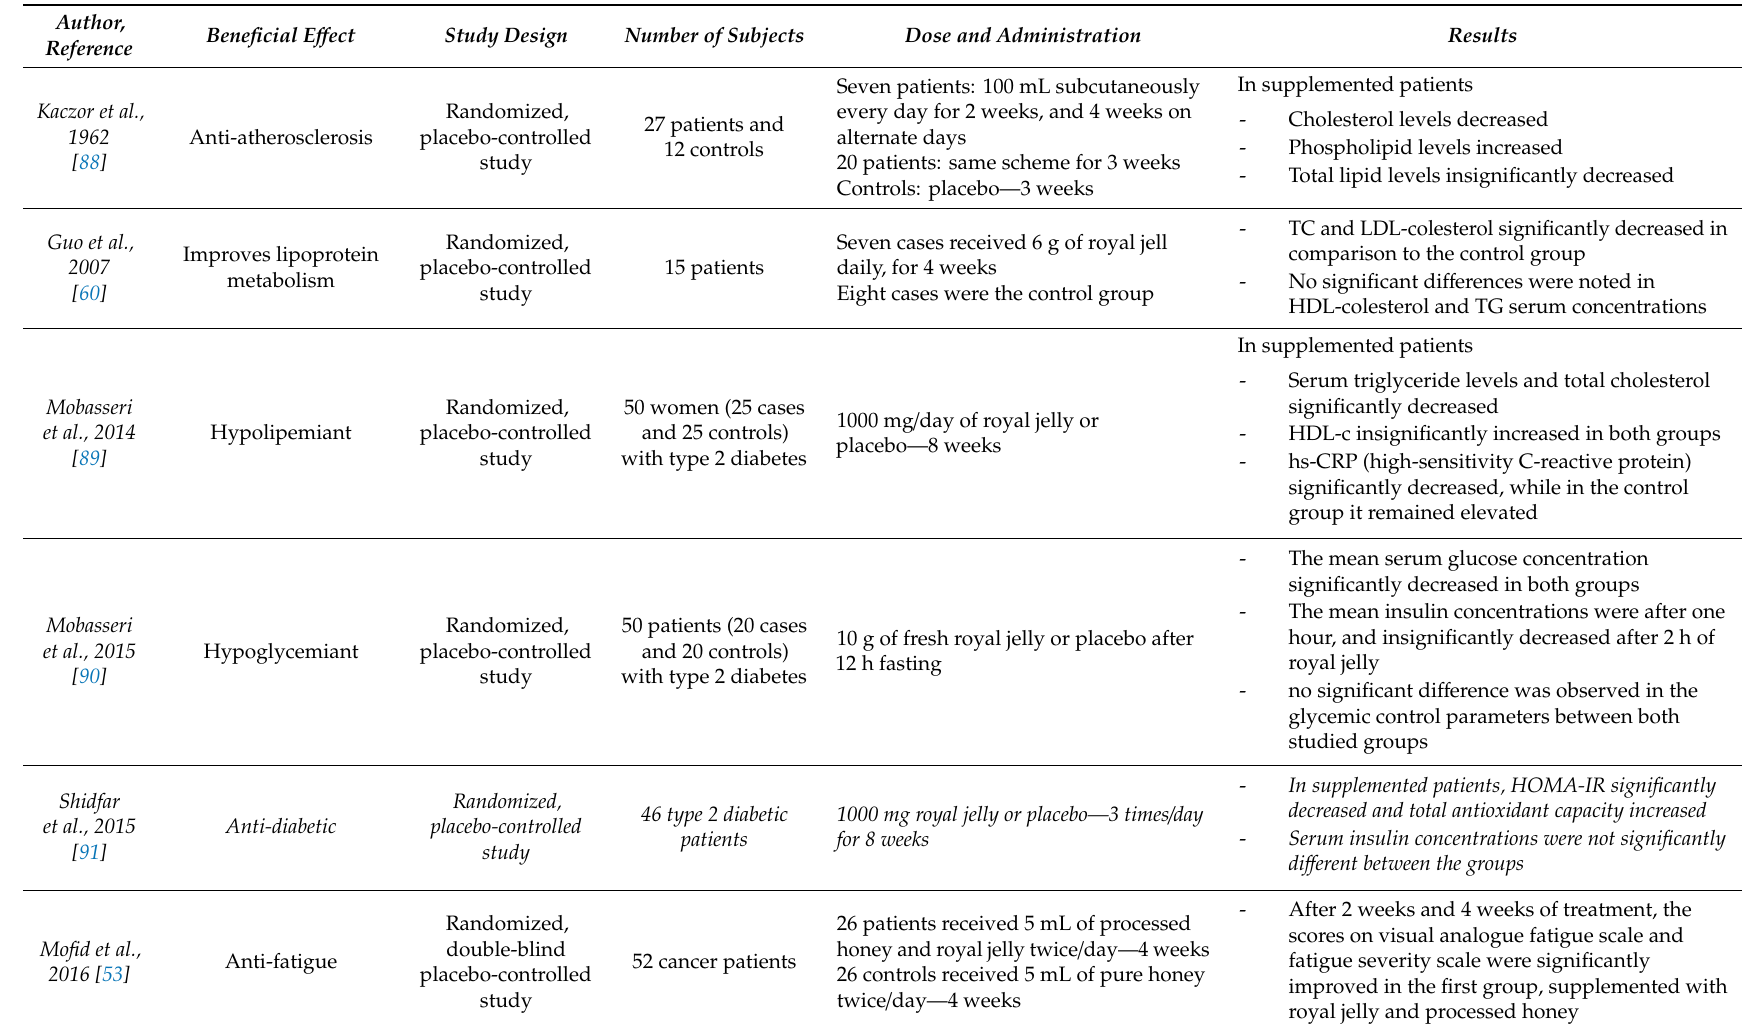
Table 1. Human studies regarding beneficial e ff ects of royal jelly in